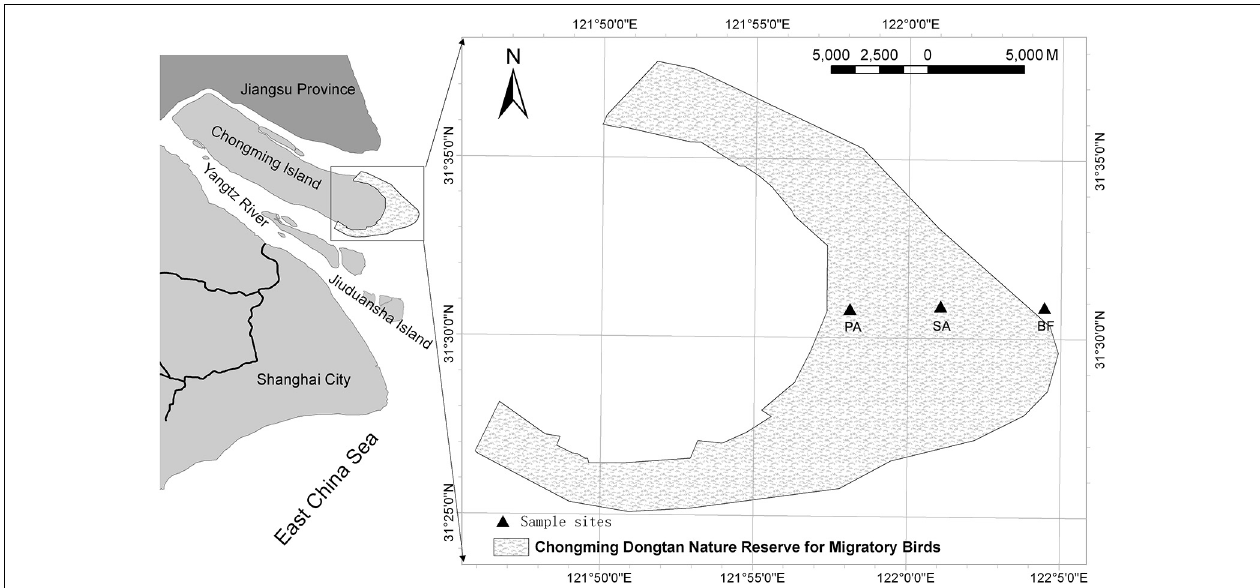
FIGURE 1 | Map of the study area with sampling sites in the Dongtan wetland, eastern Chongming Island, China. BF, soil at bare flat (no vegetative cover); SA, soil covered by Spartina alterniflora ; PA, soil covered by Phragmites australis .